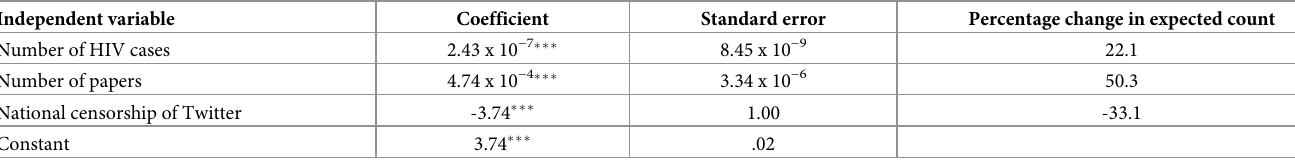
Table 3. Coefficients of a Poisson regression model with number of tweets as dependent variable (n = 89 countries).